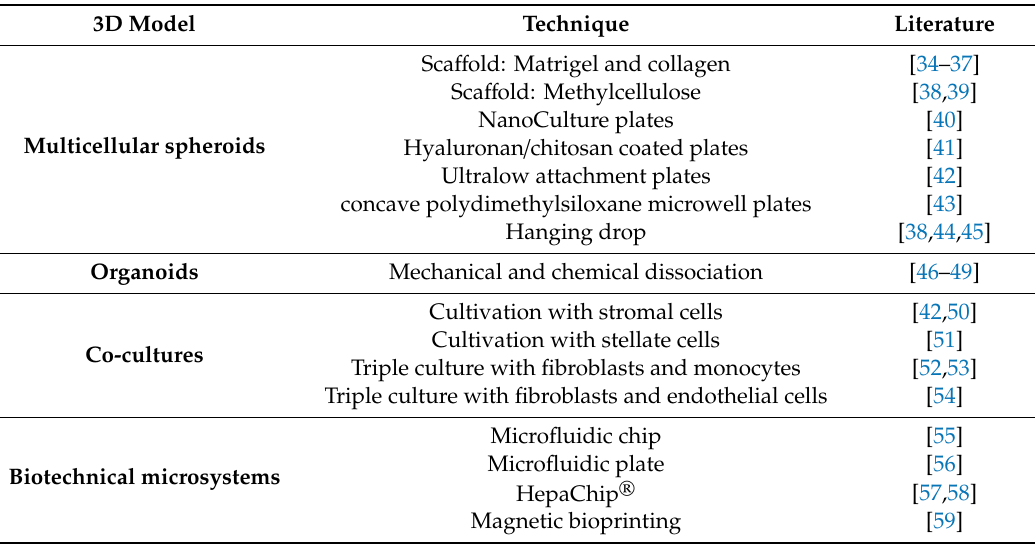
Table 1. Overview of current techniques for 3D models used in pancreatic ductal adenocarcinoma (PDAC)